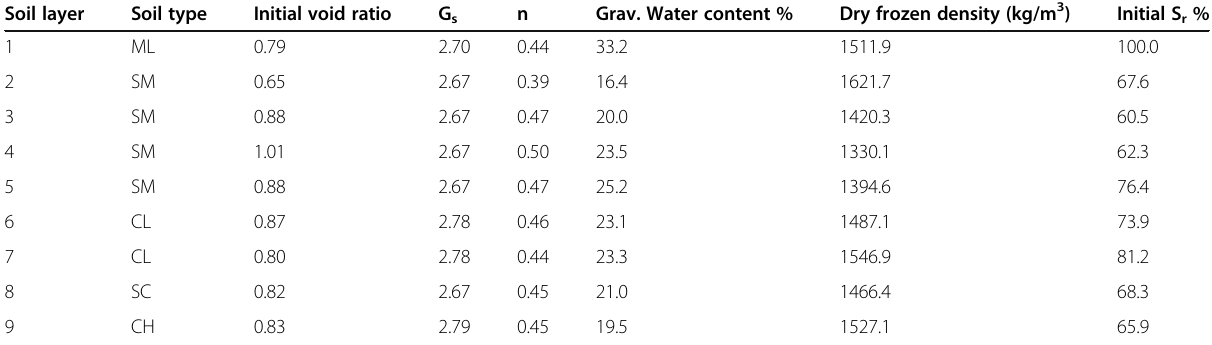
Table 1 Soil index properties important to thermal